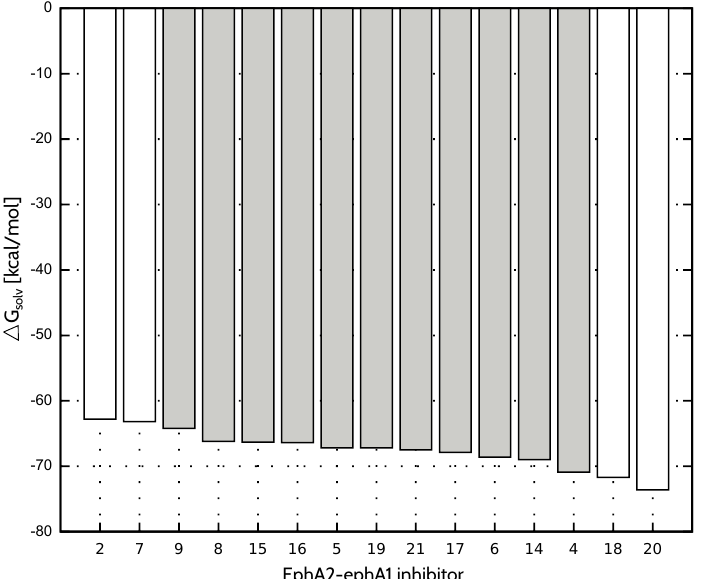
Figure 3. Solvation free energy of EphA2-ephA1 inhibitors. Compounds indicated in white were not included in the reduced ligand